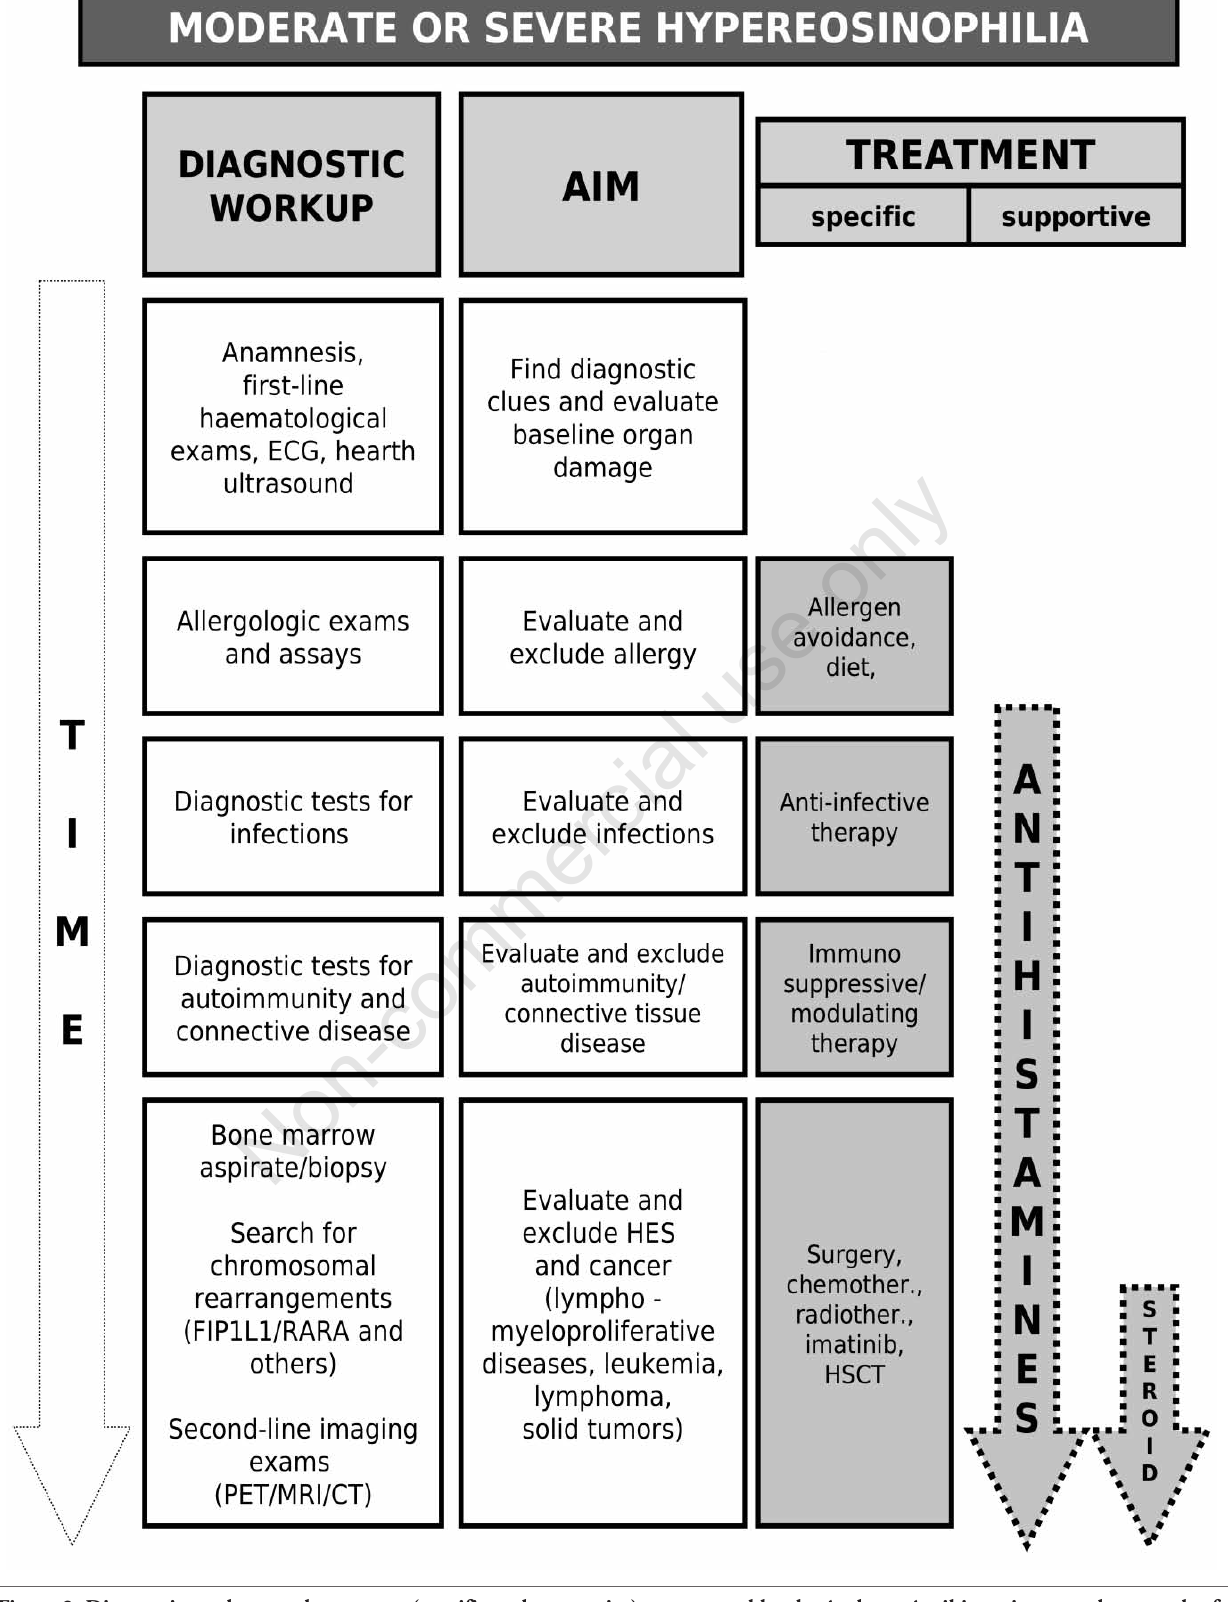
Figure 2. Diagnostic work-up and treatment (specific and supportive) as proposed by the Authors. Antihistamines may be started safe- ly and promptly to prevent organ damage, the best timing being after completing allergy exams. On the contrary, steroids should not be administered until a diagnosis of hypereosinophilic syndrome or neoplastic disease is ruled